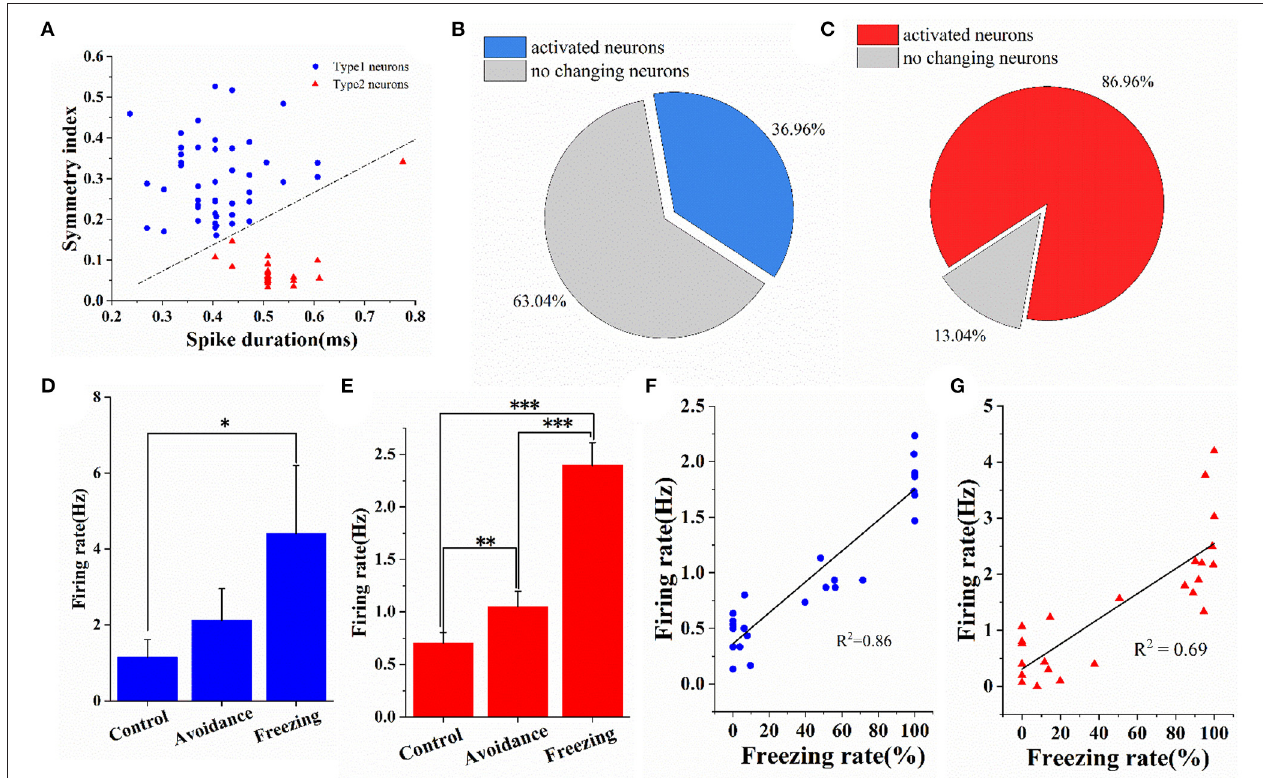
FIGURE 7 | Electrophysiological characteristics of type 1 neurons and type 2 neurons in medial amygdala under fear. (A) Classification results of type 1 neurons and type 2 neurons ( n = 69 neurons). (B,C) The proportion of type 1 neurons and type 2 neurons activated under fear. (D,E) The firing rate of activated type 1 neurons and type 2 neurons in three stages. (F,G) Linear fitting graph of one typical type 1 neuron and one typical type 2 neuron firing rate with freezing rate of mice (bin = 30s). Data are means ± SE. One-way repeated measures ANOVA. * p < 0.05; ** p < 0.01; *** p <